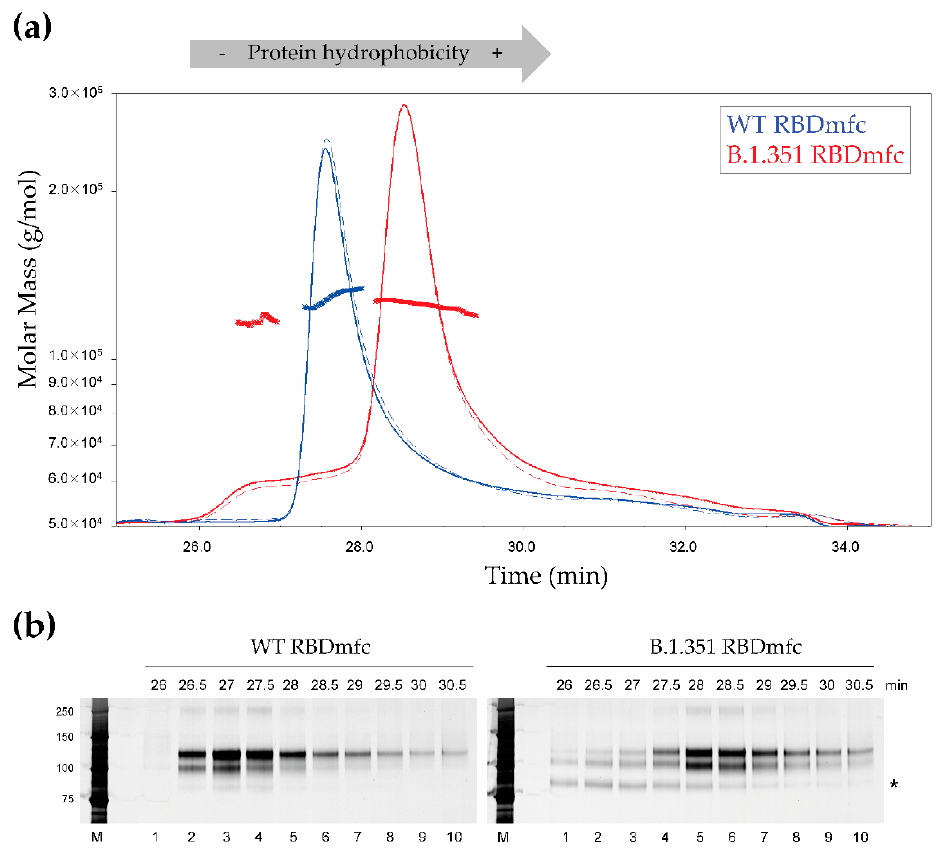
Figure 6. Hydrophobicity plot analysis of WT and B.1.351 RBDmfc proteins. ( a ) Hydrophobicity plots were determined by hydrophobic interaction chromatography hyphenated to multi-angle light scattering detection (HIC-MALS). Plain curves represent UV 280 nm absorbance (for protein concentration determination) and dotted curves represent scattered light intensity (determined by MALS). WT and B.1.351 RBDmfc protein populations show different hydrophobicity profiles, as expected from their differences in amino acid composition. However, B.1.351 but not WT RBDmfc presents a second protein population with lower hydrophobicity (see shoulder for fractions collected between 26 and 28 min). Absolute molar mass calculations (based on the light scattering theory) are depicted as a bold line across each peak, as well as above the lower hydrophobicity B.1.351 protein population eluting between 26 and 28 min. Calculated molar mass indicates a relative homogeneity in molar mass between the different protein populations. ( b ) SDS-PAGE and silver staining of purified, secreted RBDmfc proteins fractionated by HIC-MALS [see panel ( a )]. M, protein ladder (apparent MW in kDa indicated on the left); *, protein population with lower apparent MW. Fractions were named as follows: Fraction “26 min” corresponds to the fraction collected between 26 and 26.5 min in panel ( a ), fraction “26.5 min” to the fraction collected between 26.5 and 27 min, etc. Uncropped SDS-PAGE images are shown in Appendix Figure A5.